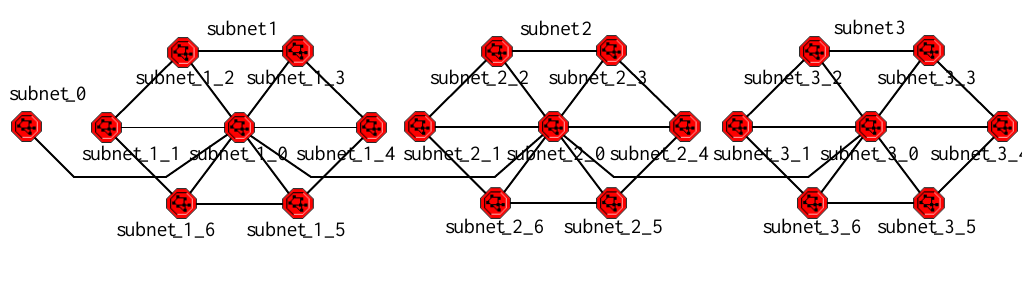
Figure 11. Simulation model.